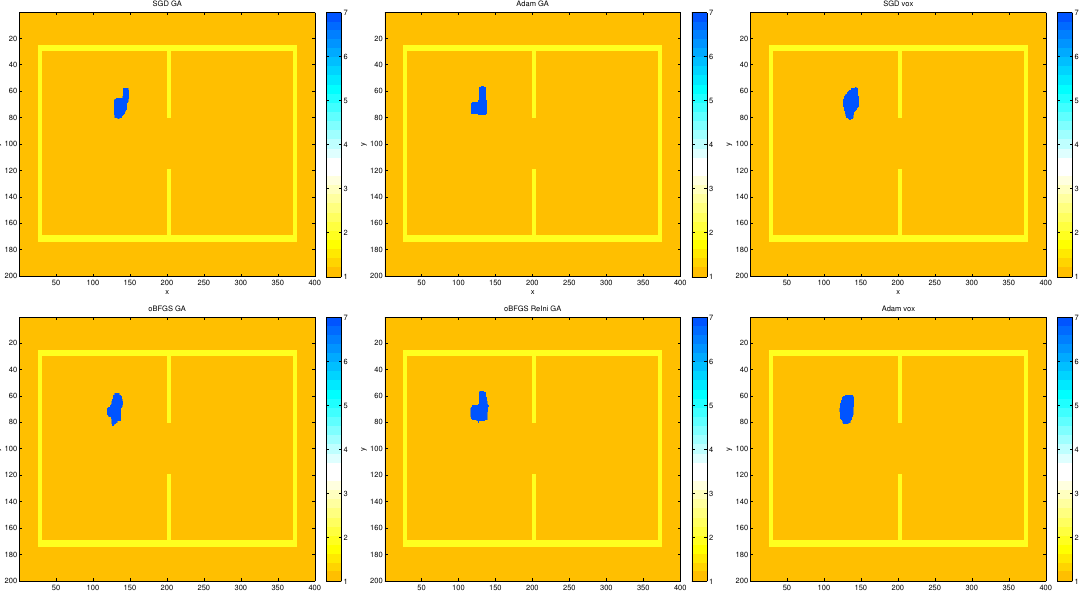
Figure 3. Final permittivity profiles achieved. Top row from left to right: SGD GA, Adam GA and SGD vox. Bottom row from left to right: oBFGS GA, oBFGS ReIni GA, Adam vox.